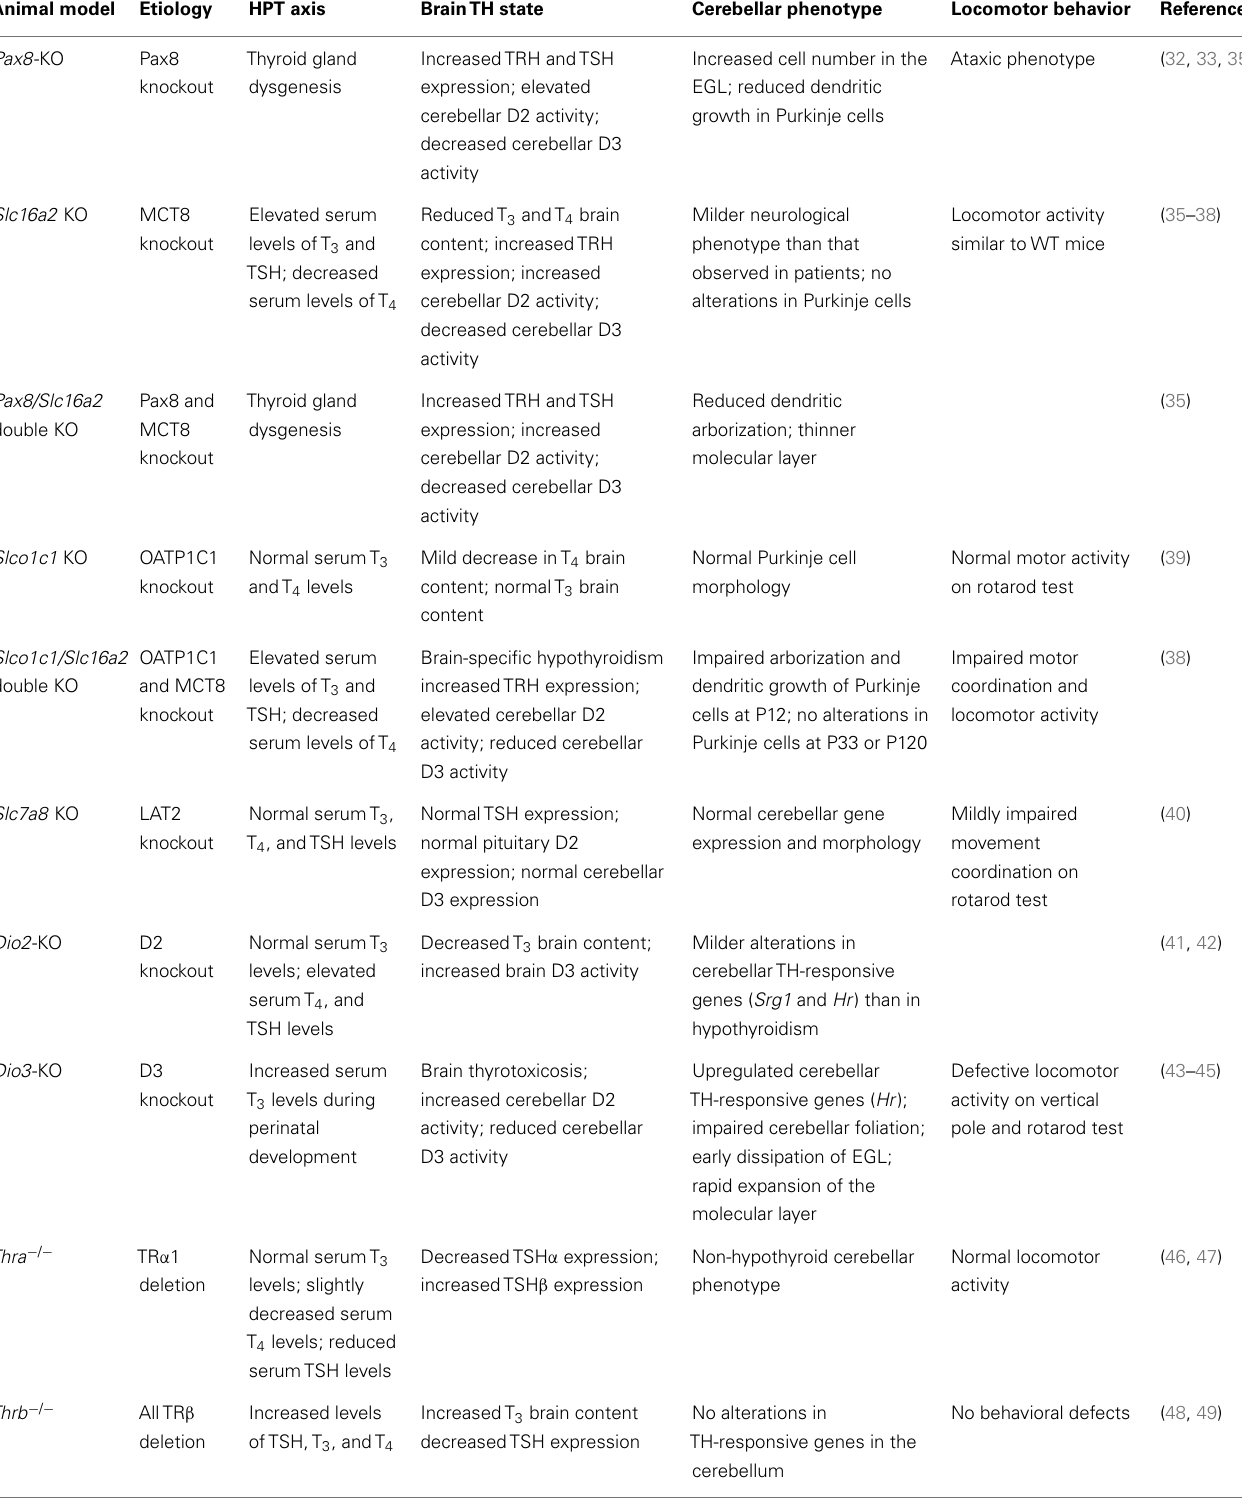
Table 1 | Summary of mutant animal models and their cerebellar phenotypes . Animal model